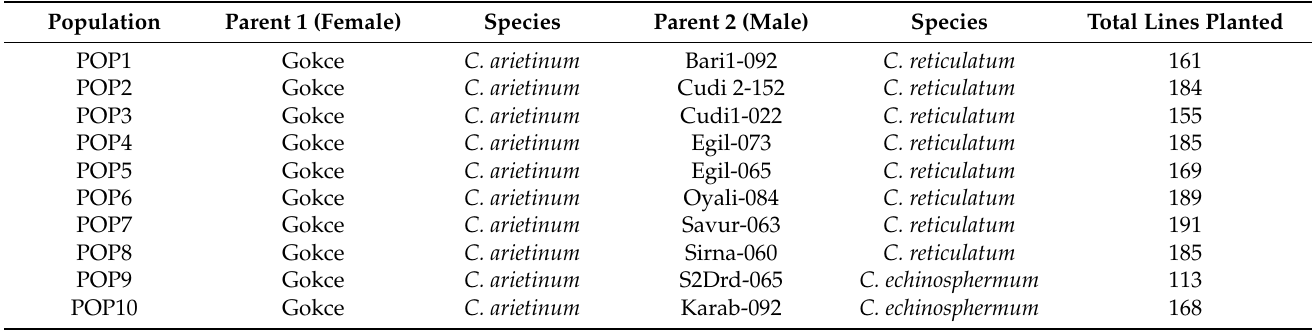
Table 1. Chickpea NAM populations, their pedigrees, and the number of genotypes for generation